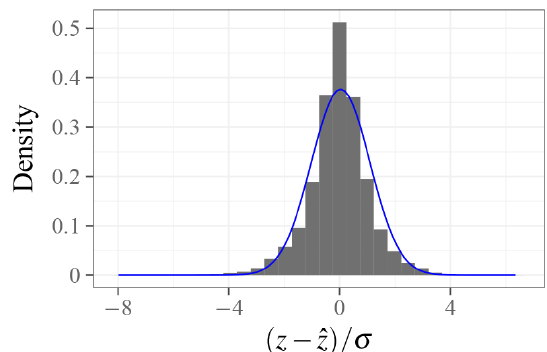
Figure 8. Distribution function of cloud base error divided by pre- dicted uncertainty; for the ideal case of unbiased z and unbiased uncertainty, the distribution would be Gaussian with zero mean and unit standard deviation. The superimposed least-squares Gaussian fit (blue line) has a mean of 0.04 and standard deviation of